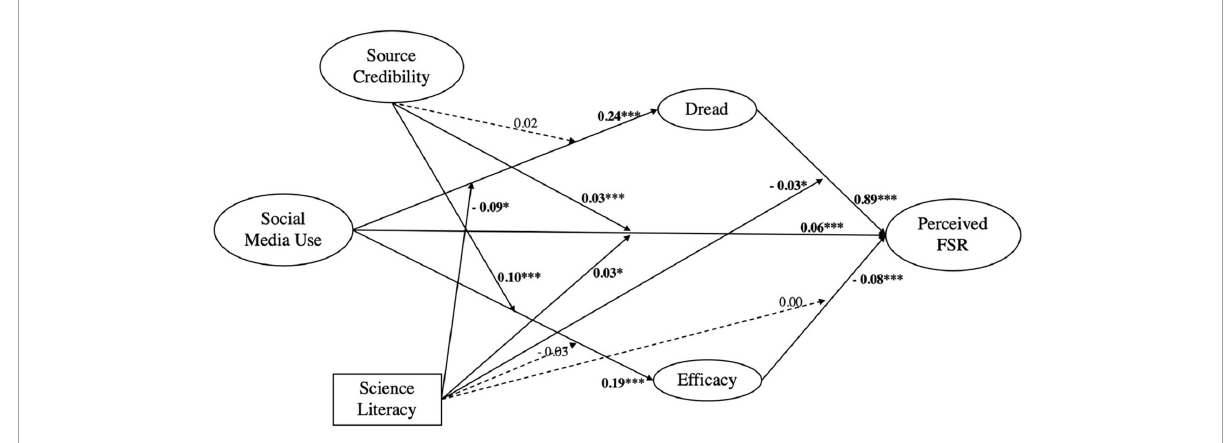
FIGURE2 Path coefficients of regression analysis results ( N = 2,015). * p < 0.05, *** p < 0.001, and all coefficients are standardized